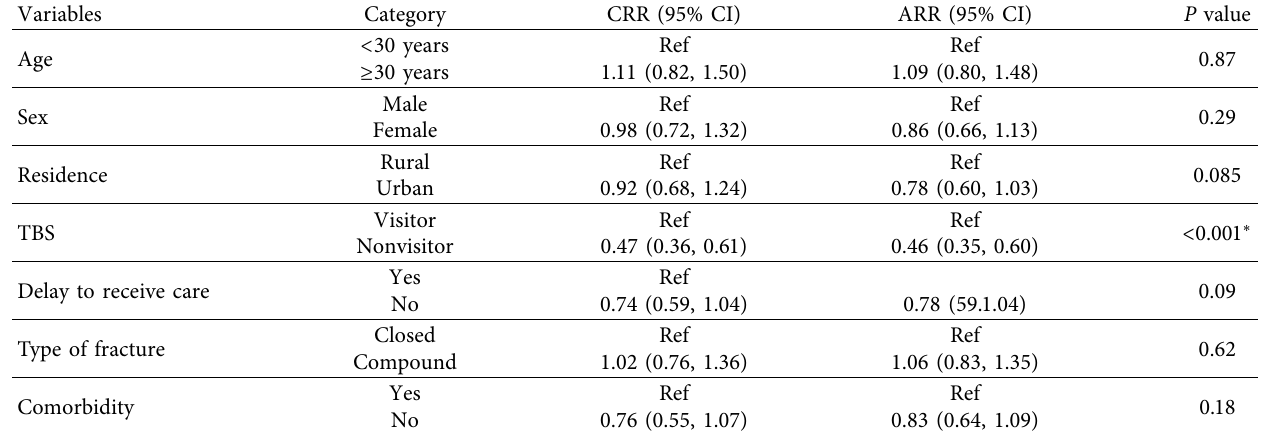
Table 4: Multivariable regression analysis of outcome of patients with fracture in DMCSH,